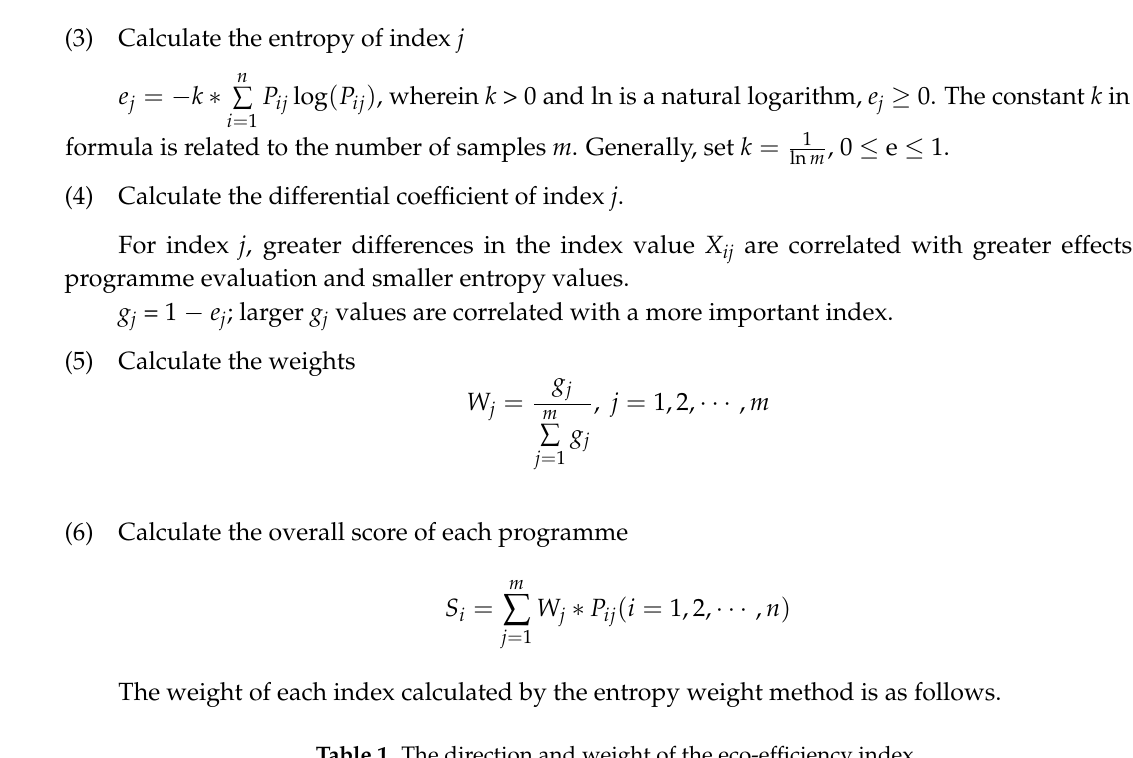
Table 1. The direction and weight of the eco-efficiency